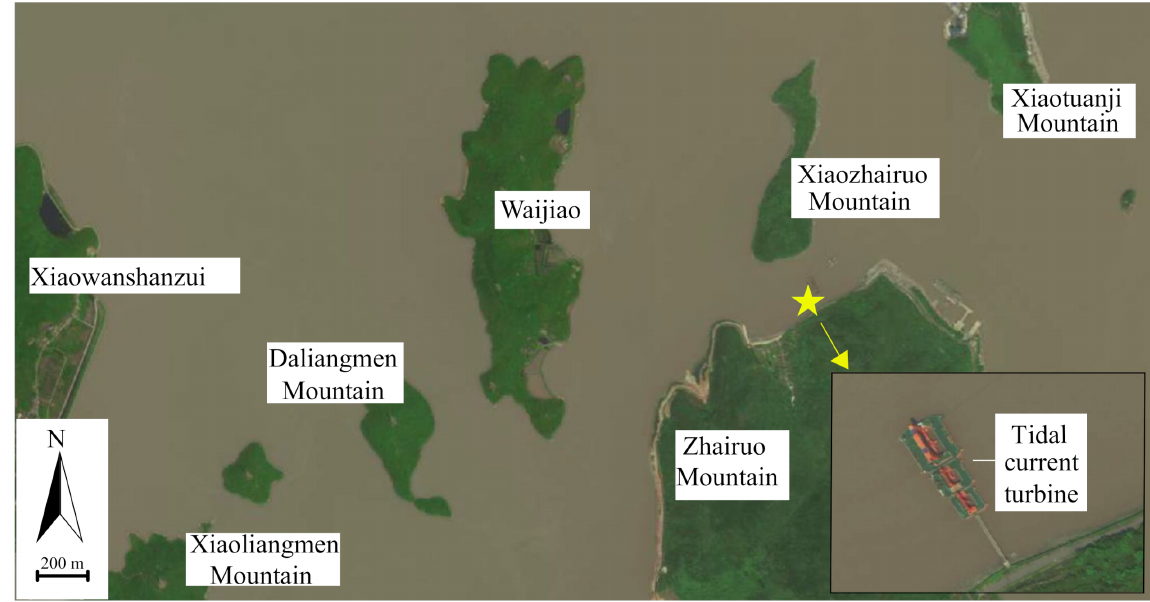
Figure 2. Map of the location of the tidal current